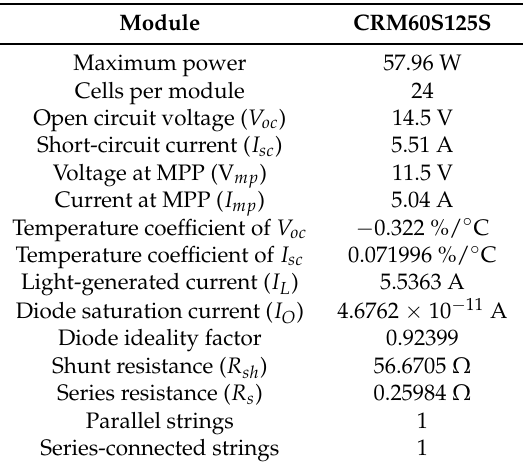
Table 3. PV array for low power simulation parameters.